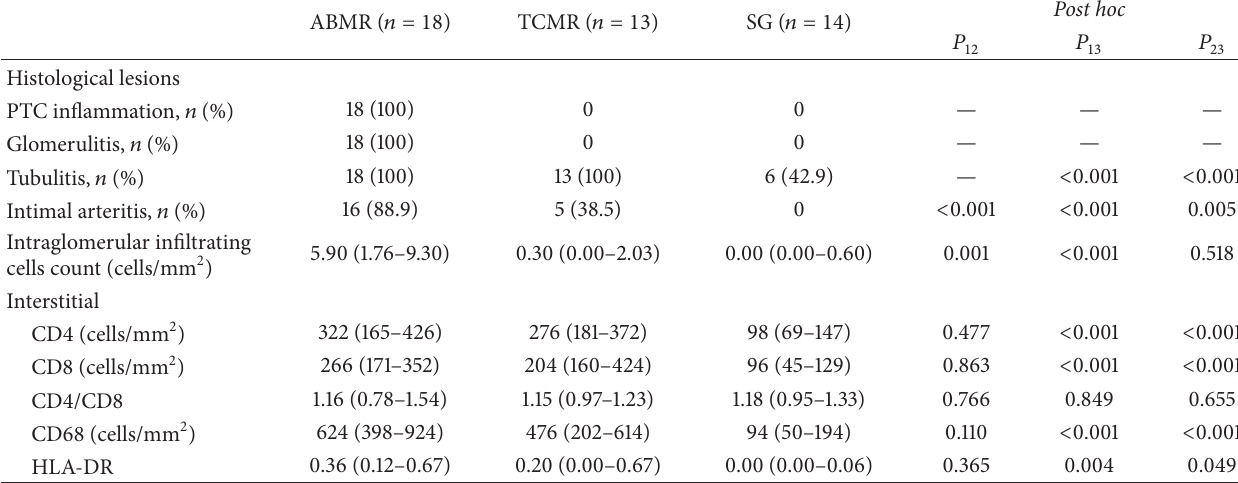
Table 2: Histological characteristics in different groups.